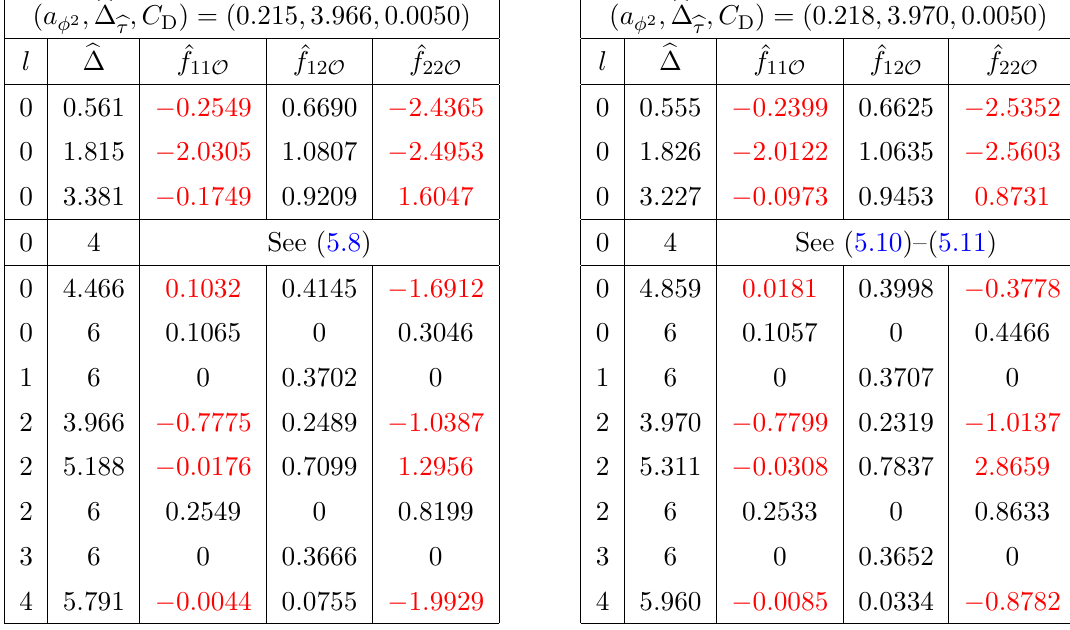
, b ∆ , C D ) space. The point associated with φ 2 b τ , b ∆ ) — it is the kink in figure 2. Due φ 2 b τ